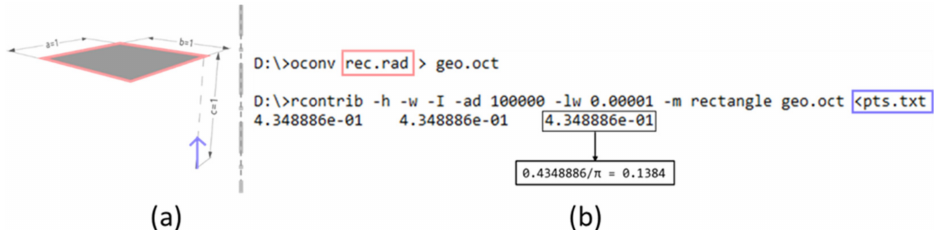
Figure 11. View factor calculation between a differential planar element and finite parallel rectangle. The geometry is shown in ( a ) and a screen-capture of the corresponding RADIANCE calculation is shown in ( b